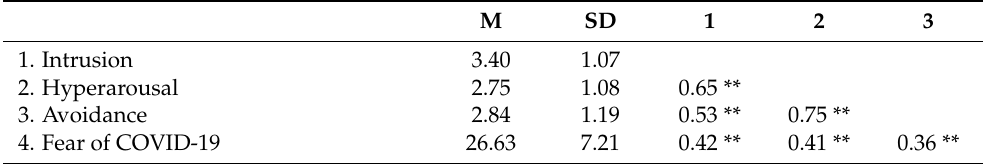
Table 4. Mean, standard deviation, and correlations among the study variables in Study 1. M